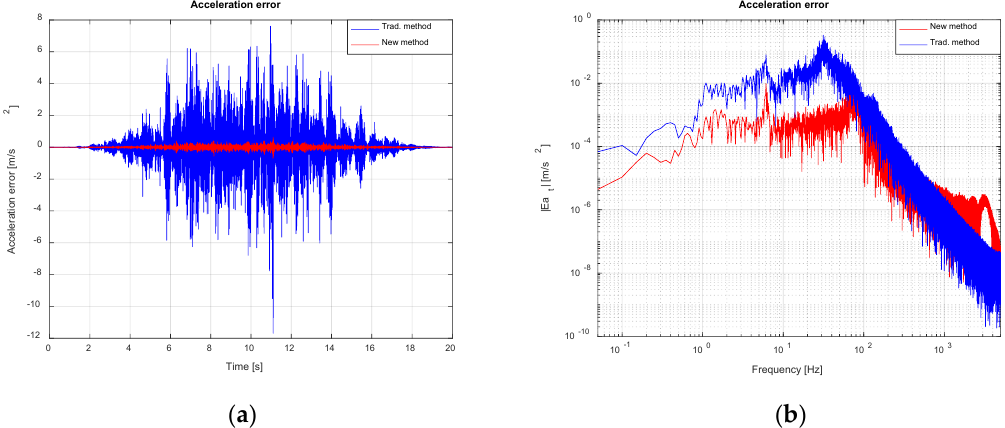
Figure 28. Comparison between classical and new control methods. Acceleration error: ( a ) Time domain; ( b ) Frequency domain.